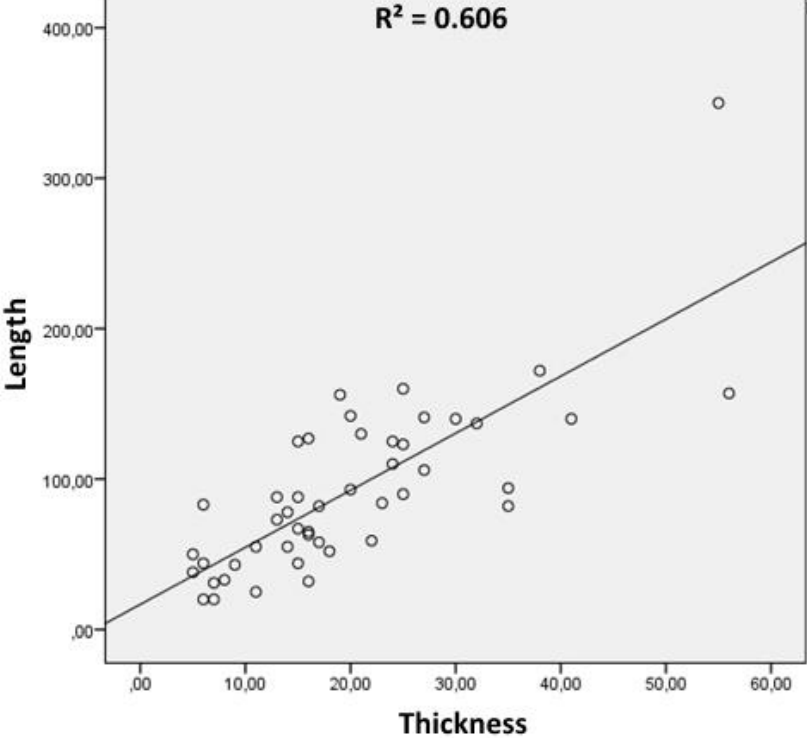
Figure 4. Coefficient of determination: R² Correlation of debitage/core-flakes length and thickness.